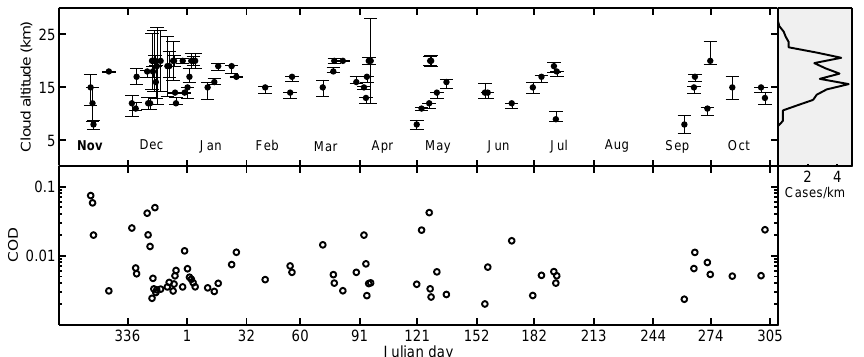
Figure 18. Retrieved cloud altitudes (upper panel) and COD (lower panel) between November 2004 and October 2005. The grey panel on the right shows the histogram of cloud altitude (caseskm − 1